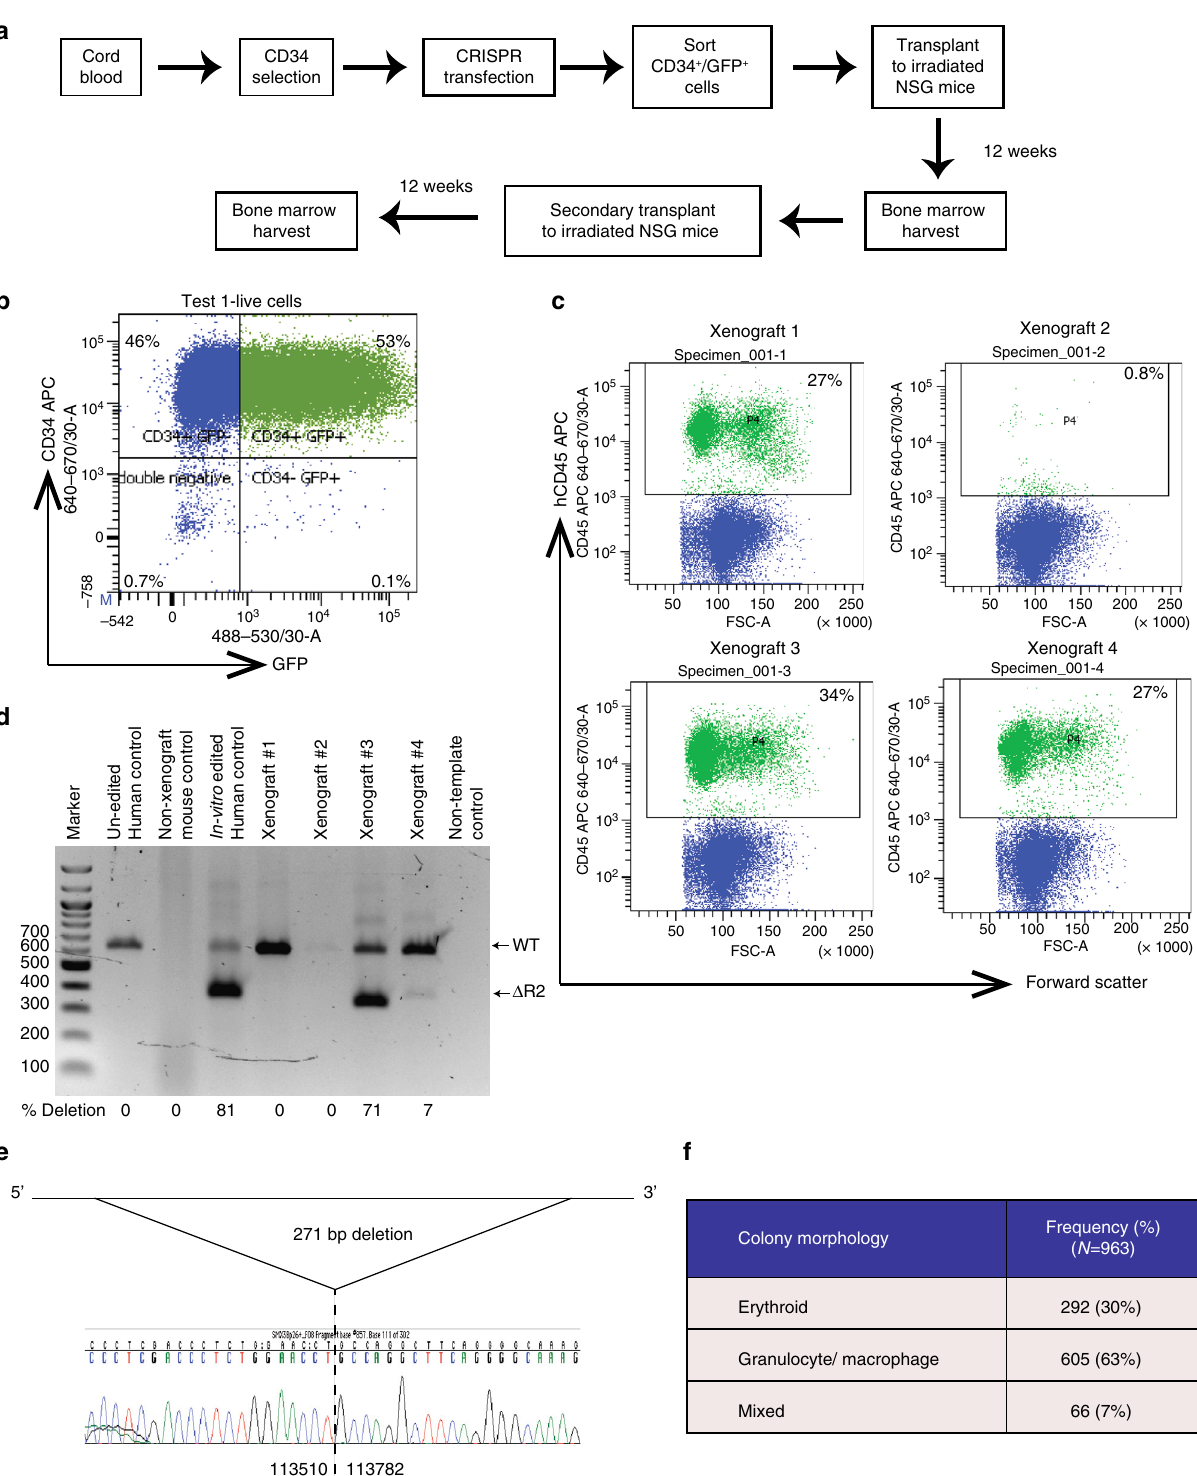
Fig. 4 Xenograft assay. a Schematic of the work fl ow of mouse xenograft experiment. b Flow cytometry analysis of cells following CRISPR transfection demonstrating transfected (positive for GFP) CD34+ HSPCs. Gating strategy is shown in Supplementary Fig. 10b. c Flow cytometry plots of harvested bone marrow from xenograft mice gated for live cells demonstrating hCD45 expression. Gating strategy is shown in Supplementary Fig. 10c. d Gel electrophoresis image of genomic DNA extracted from human cells obtained from xenograft mouse analyzed by PCR demonstrating genome-edited bands. e Characterization of deletion break points by sequencing (co-ordinates from Hum Mar 2006 (NCBI36/hg18) Assembly) f Morphological analysis of hematopoietic colonies grown in methyl cellulose which were generated by HSCs harvested from secondary transplant mice (two independent